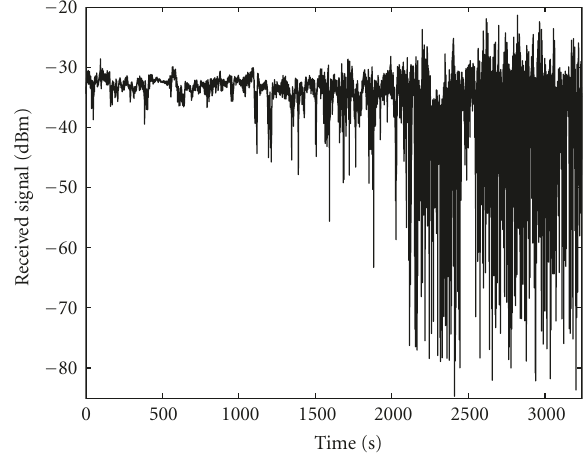
Figure 1: Measured signal fading after propagating through dry leaved deciduous trees (Site 1) at 29GHz. A sampling rate of 500 Hz was used to collect the signal.